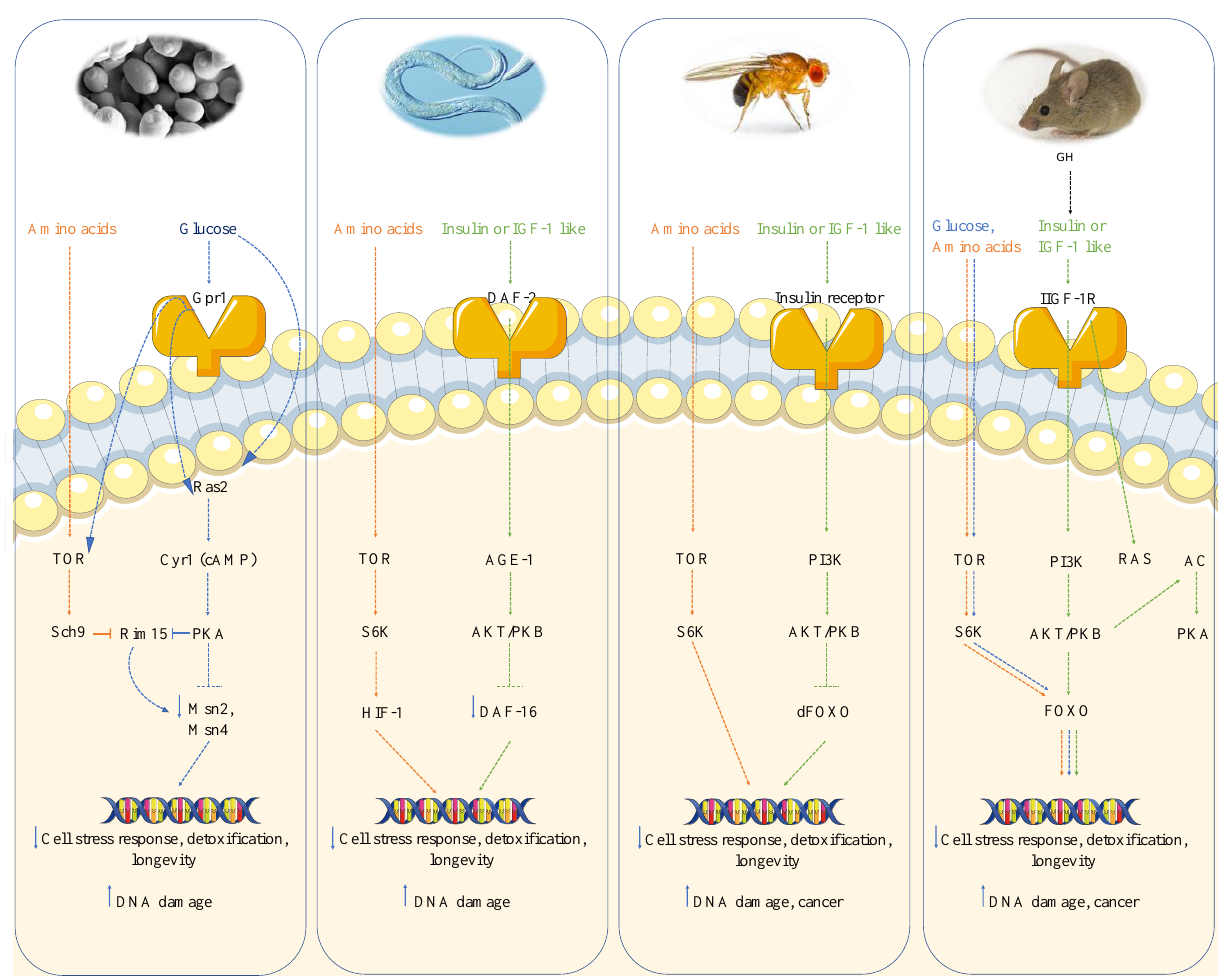
Figure 1. Conserved nutrient signaling pathways in yeast, worms, flies and mammals. A schematic model of the conserved nutrient-signaling pathways that regulate stress response mechanisms, DNA damage, longevity and cancer in different model organisms [22]. In Saccharomyces cerevisiae , glucose and amino acids activate Ras/AC/PKA and TOR/Sch9 path- ways, respectively. Their activation leads to serine-threonine kinase Rim15 inhibition and consequently to a lowering in Msn2/Msn4 stress resistance transcription factors. These mechanisms promote aging in part by decreasing cell stress response and repair thus increasing DNA damage [20]. In Caenorhabditis elegans , insulin/IGF-1 receptor like (daf-2) signaling, through the activation of AKT/PKB pathway, inactivates the Forkhead FoxO transcription factor daf-16, which is involved in the regulation of genes implicated in the cellular stress response and protection against free radicals. As in yeast, also in worms, amino acids can activate the TOR/S6K pathway, accelerating the aging process [44]. Analogously to worms, in Drosophila melanogaster growth factors and amino acids activate AKT/PKB and TOR/S6K pathways, respectively [47]. The activation of TOR/S6K, PI3K/AKT and Ras/AC/PKA pathways, mediated by glucose, amino acids and IGF-1 like signaling, is also maintained in rodents and other mammals, suggesting that these nutrient-sensing pathways, involved in longevity and stress-response mechanisms, are conserved, in part, from the simplest model organism to humans